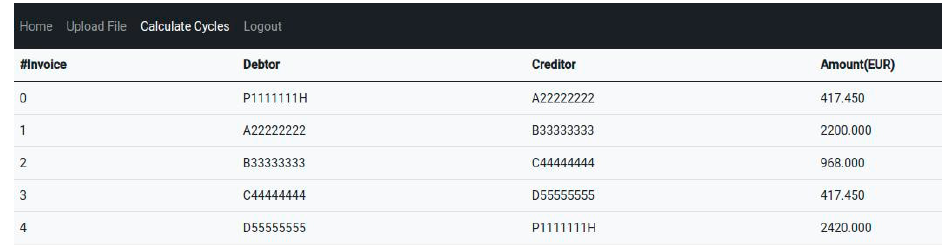
11 of 15 Algorithm 1. Algorithm for finding debt cycles between companies.